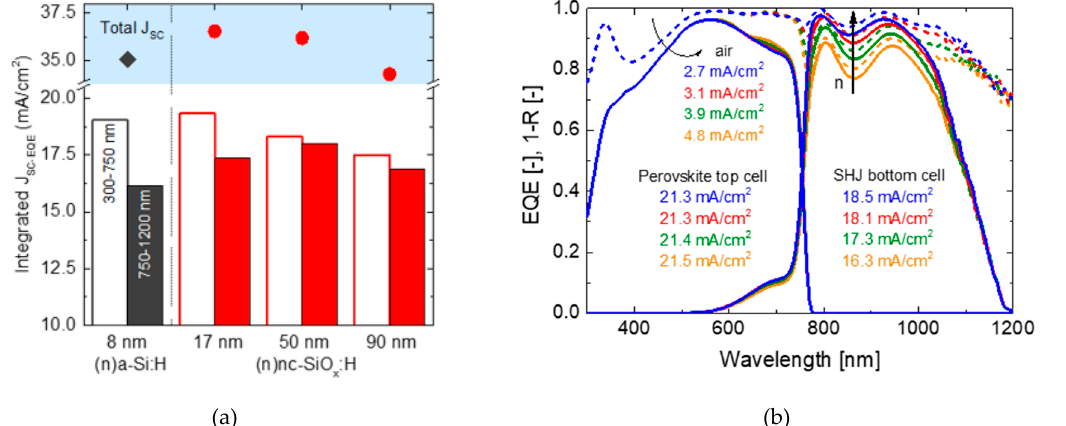
Figure 5. ( a ) Experimental current densities from external quantum efficiency (EQE) spectra ( J SC-EQE ) of silicon heterojunction (SHJ) solar cells with a flat front side. The doped front layer is (n)a-Si:H or (n)nc-SiO x :H with variable thickness. Top part of the graph reports the total J SC-EQE , whereas the bottom shows the integrated value below/above 750 nm. Data adapted from [74]. ( b ) Simulated absorption in the absorbers (solid line) and 1-total reflection (dashed line) profiles of monolithic tandem devices on flat front side bottom cell with 50 nm (n)nc-SiO x :H layer and increased refractive index (arrow). The values represent the integrated currents absorbed in the perovskite and c-S absorbers and the losses due to reflection to the air. Figure adapted from [73].